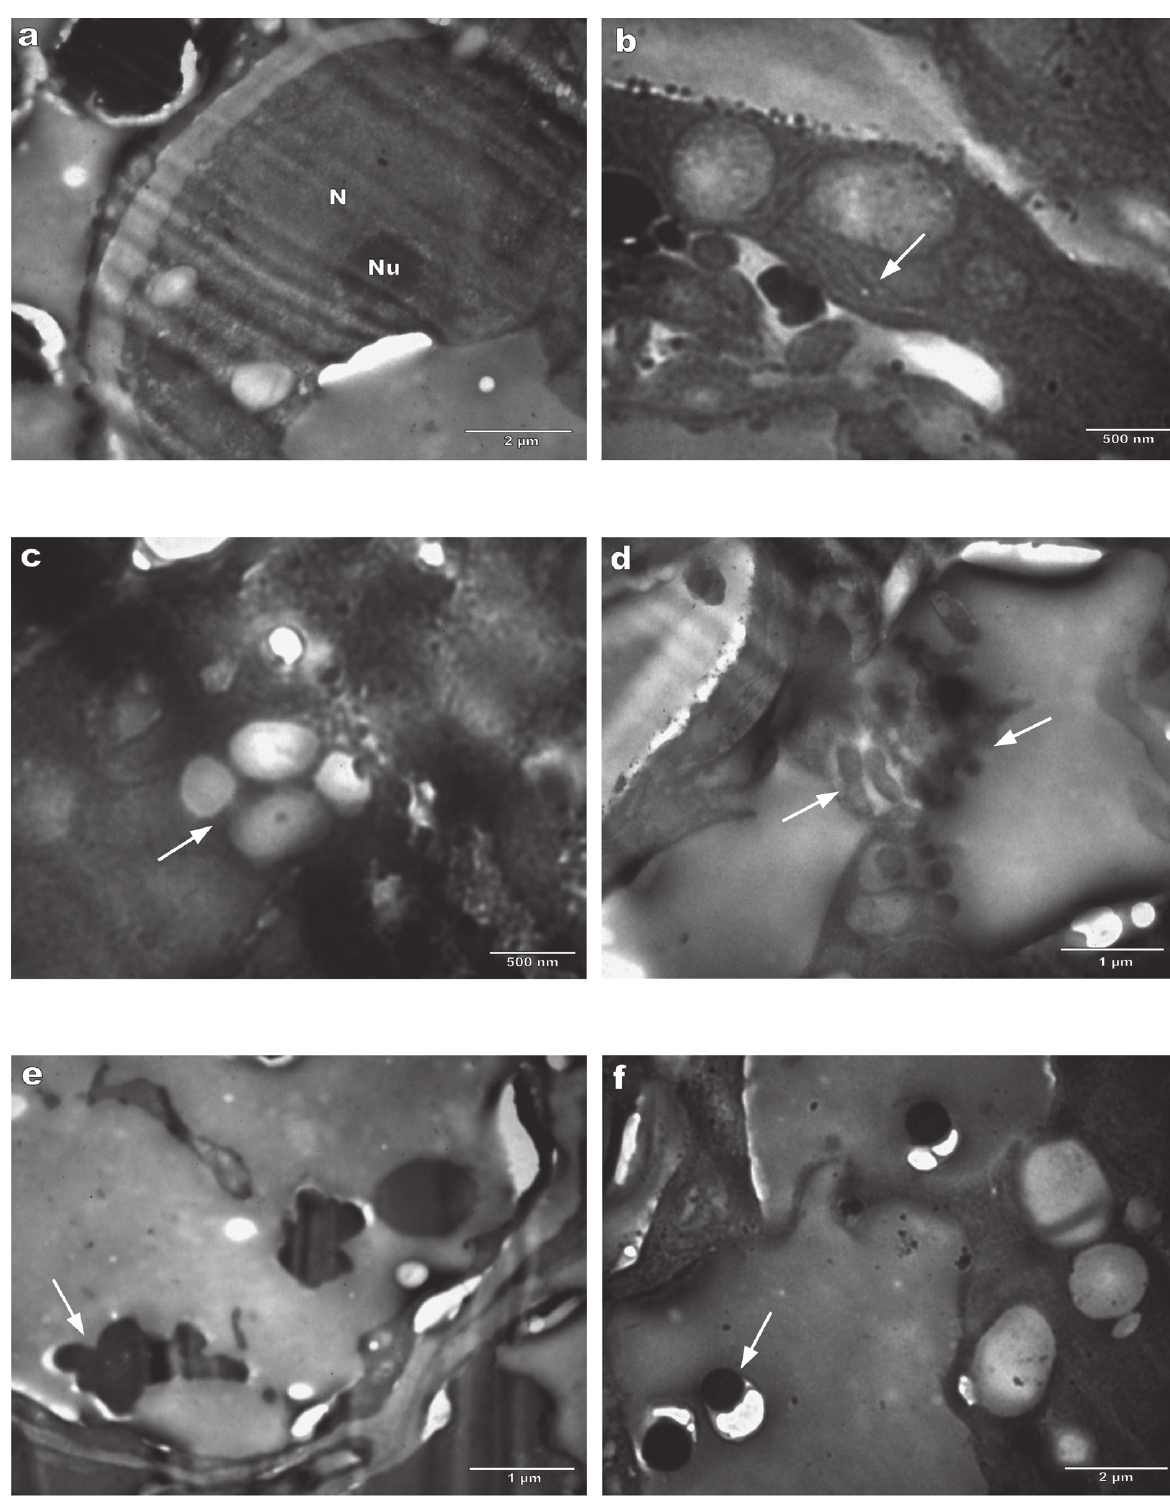
Figure 8 - Transmission electron micrographs of the callus Type 3. A) Large nucleus, nucleolus and thick cell wall. B) Endoplasmic reticulum (arrows). C) Numerous amyloplasts (arrows). D) Mitochondria (arrows) E) and F) Phenols